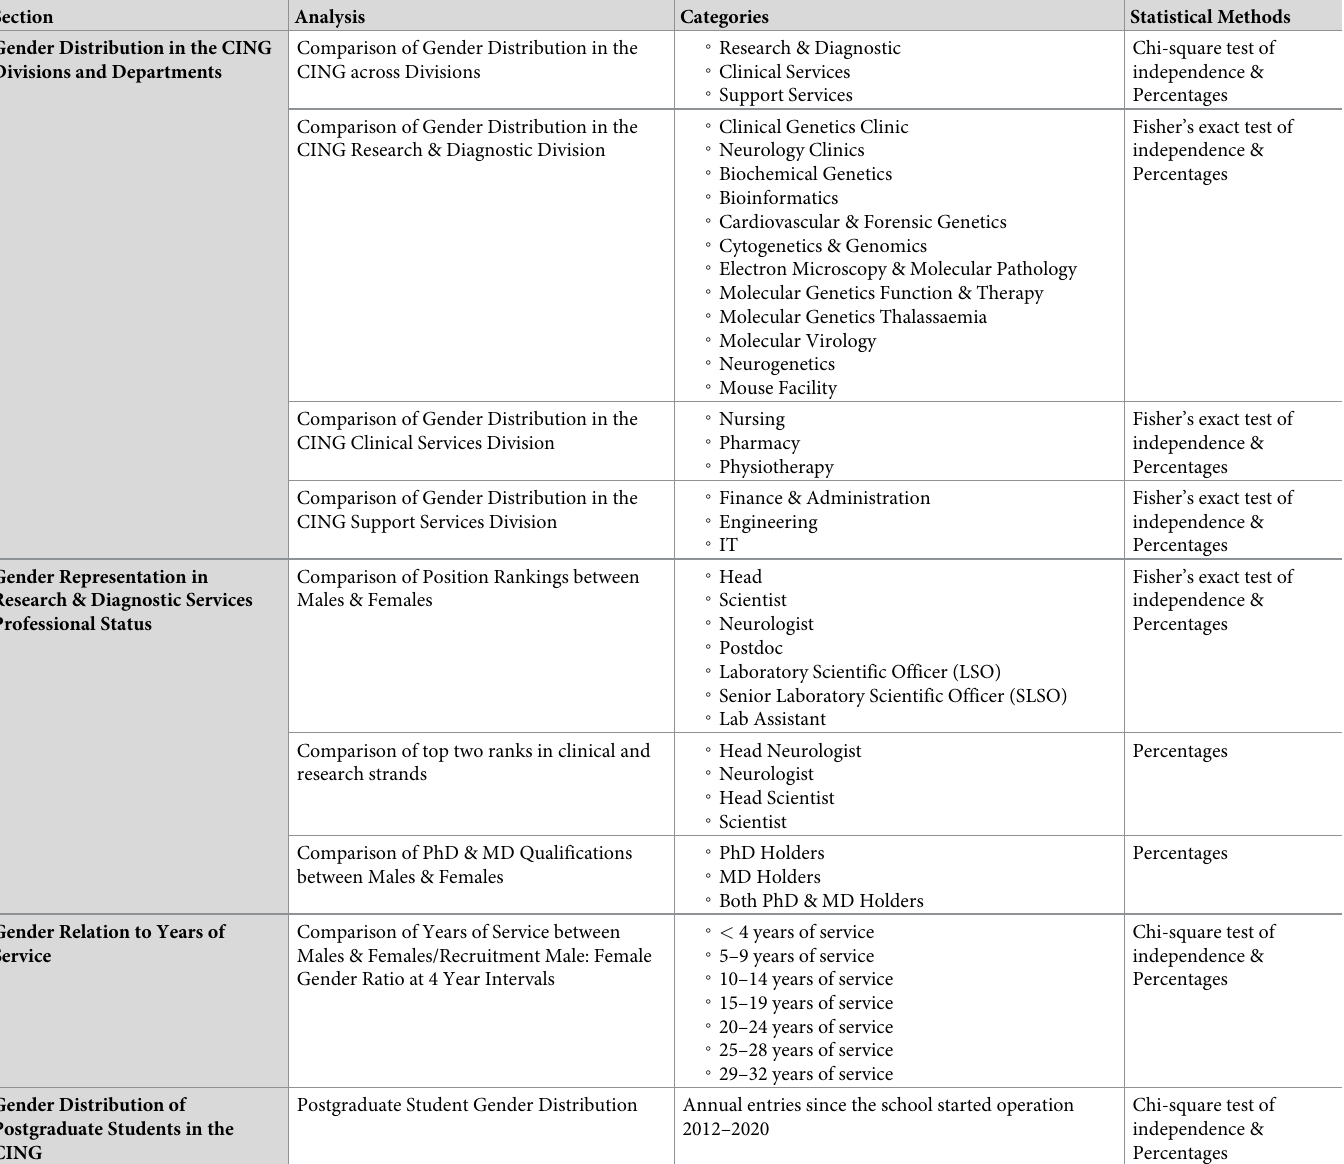
Table 1. Methods for gender distribution of employees in the CING